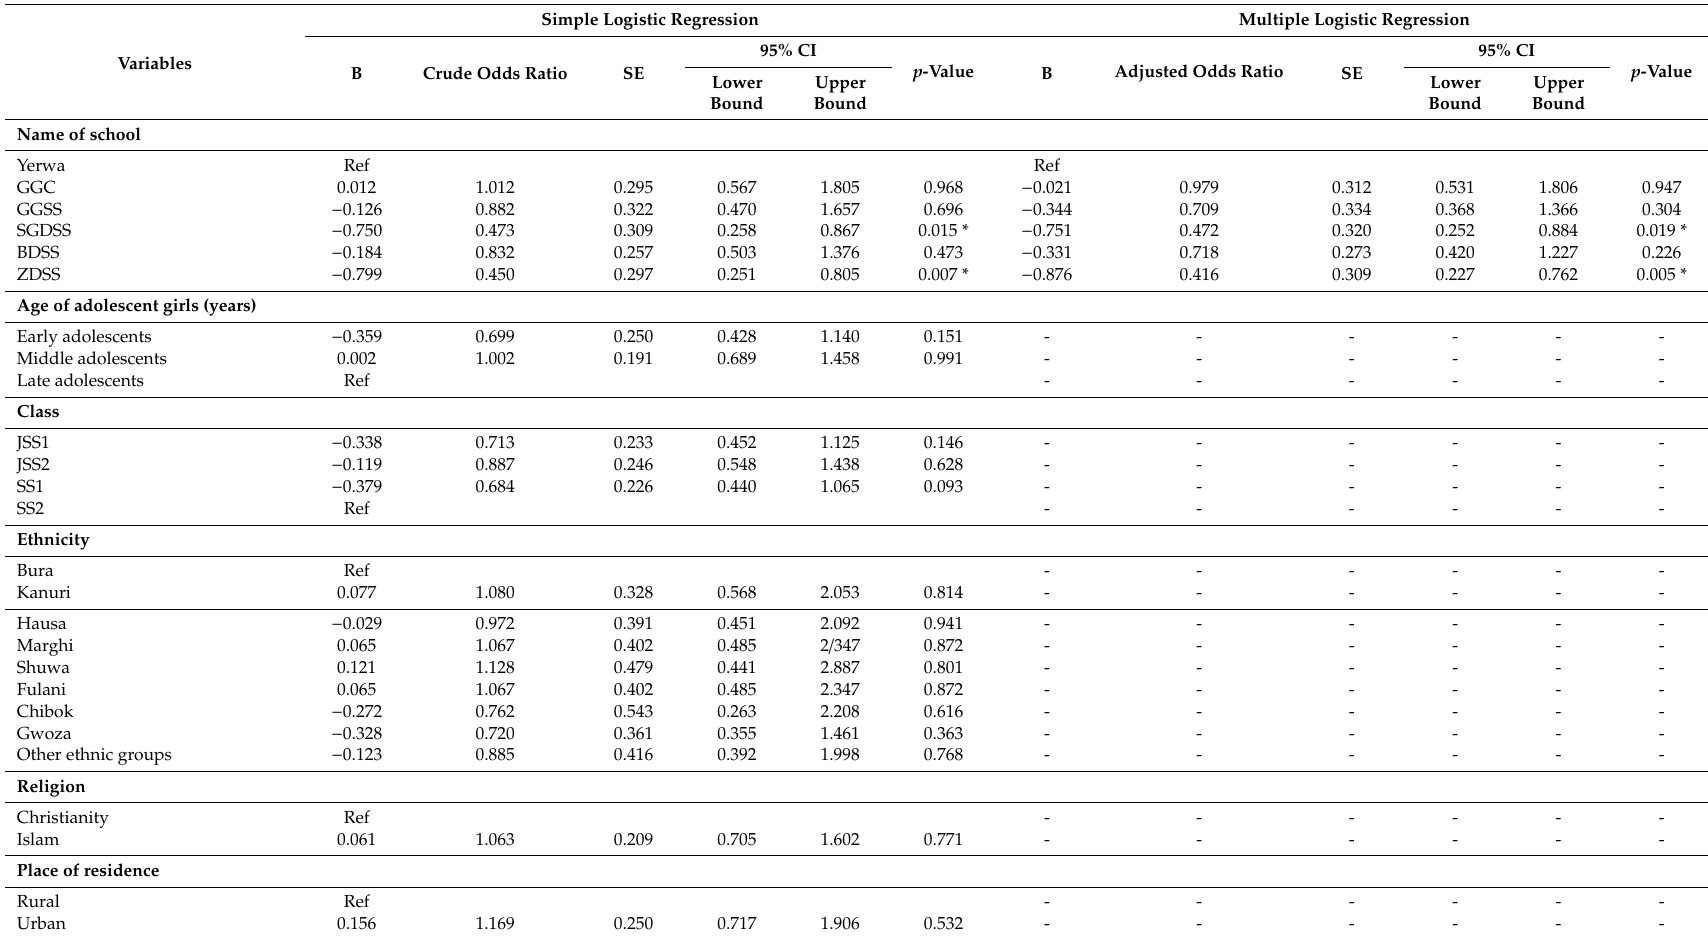
Table 7. Predictors of